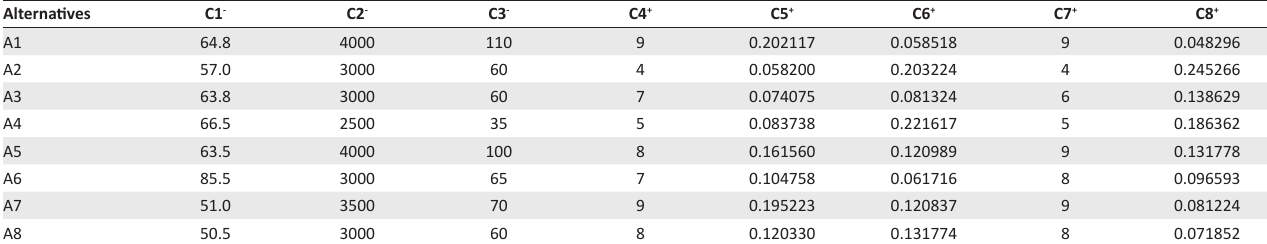
TABLE 2: Initial decision matrix.